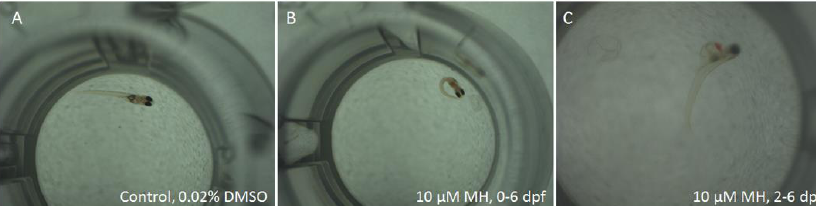
derivatives allosterically modulate GABAA receptors and act as strong partial agonists. Bioorg. Med. Chem. 2015 , 23 , 6757–6762.